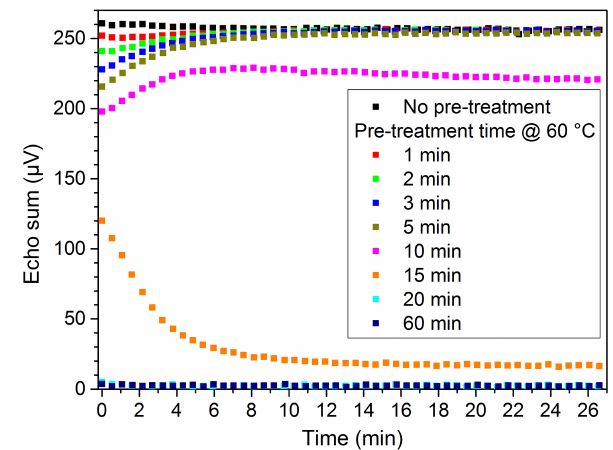
Figure 19. Comparison of peak areas from DSC measurements and echo sums from NMR experiments at the same times for the 2C adhesive (DELO-DUOPOX AD840) cured at room temperature.